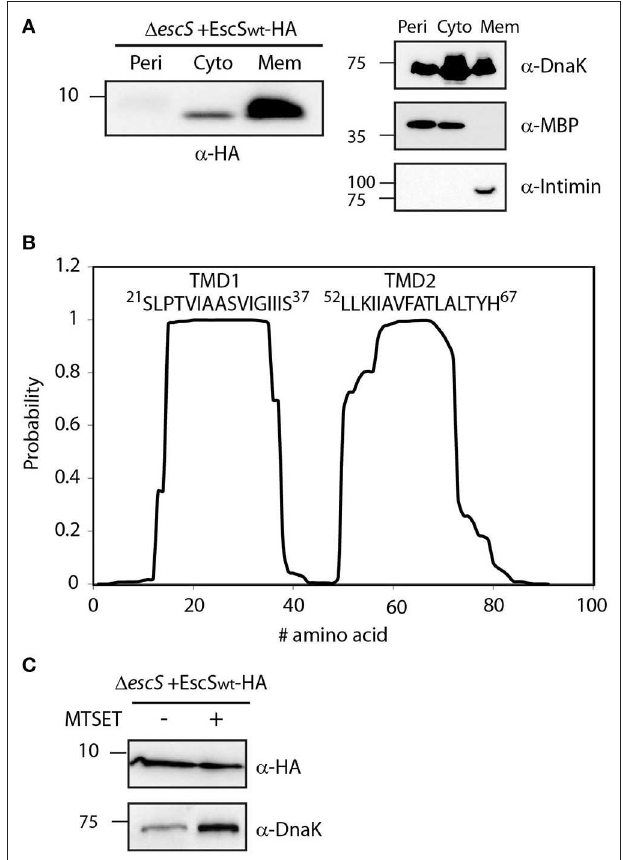
FIGURE 2 | EscS localizes to the membrane fraction and its N-terminal cysteine residue is inaccessible. (A) 1 escS EPEC carrying the EscS wt -HA vector were grown under T3S-inducing conditions and fractionated into periplasmic (Peri), cytoplasmic (Cyto), and membrane (Mem) fractions. The samples were separated on an SDS-PAGE and analyzed by western blotting using anti-HA antibody. To confirm correct bacterial fractionation, the western blots were probed with anti-DnaK (cytoplasmic marker), anti-MBP (periplasmic marker), and anti-intimin (membrane marker) antibodies. (B) Analysis of the EscS sequence to rank the probability of each amino acid to be localized within the membrane, using the prediction software TMHMM (Krogh et al., 2001). Two distinct TMDs (TMD1 and TMD2) were identified. The sequences of the core TMDs are presented. (C) Spheroplasts of EPEC carrying the EscS wt -HA were grown under T3SS-inducing conditions and treated with ( + ) or without (–) the blocking reagent MTSET. Unblocked cysteine residues were labeled with MTSEA-biotin and biotinylated proteins were recovered with streptavidin-sepharose resin and analyzed by SDS-PAGE and western blot analysis using anti-HA antibody. The samples were also analyzed using an anti-DnaK antibody as a control for inaccessible protein.